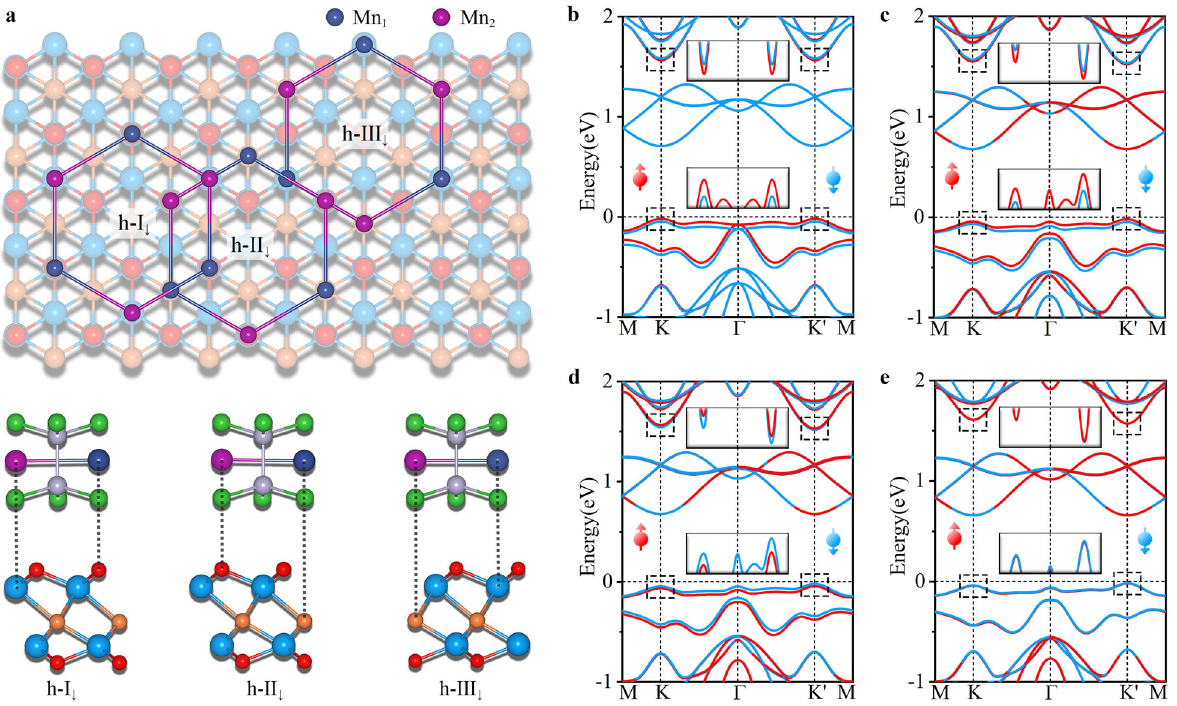
Fig. 2 Structural con fi gurations and band structures. a Crystal structures of h-I ↓ , h-II ↓ and h-III ↓ . Band structures of h-I ↓ b without and c with considering SOC. d Band structure of h-II ↓ with considering SOC. e Band structure of h-III ↓ with considering SOC. Blue and red lines in b – e correspond to spin-down and spin-up states, respectively. The Fermi level is set to 0